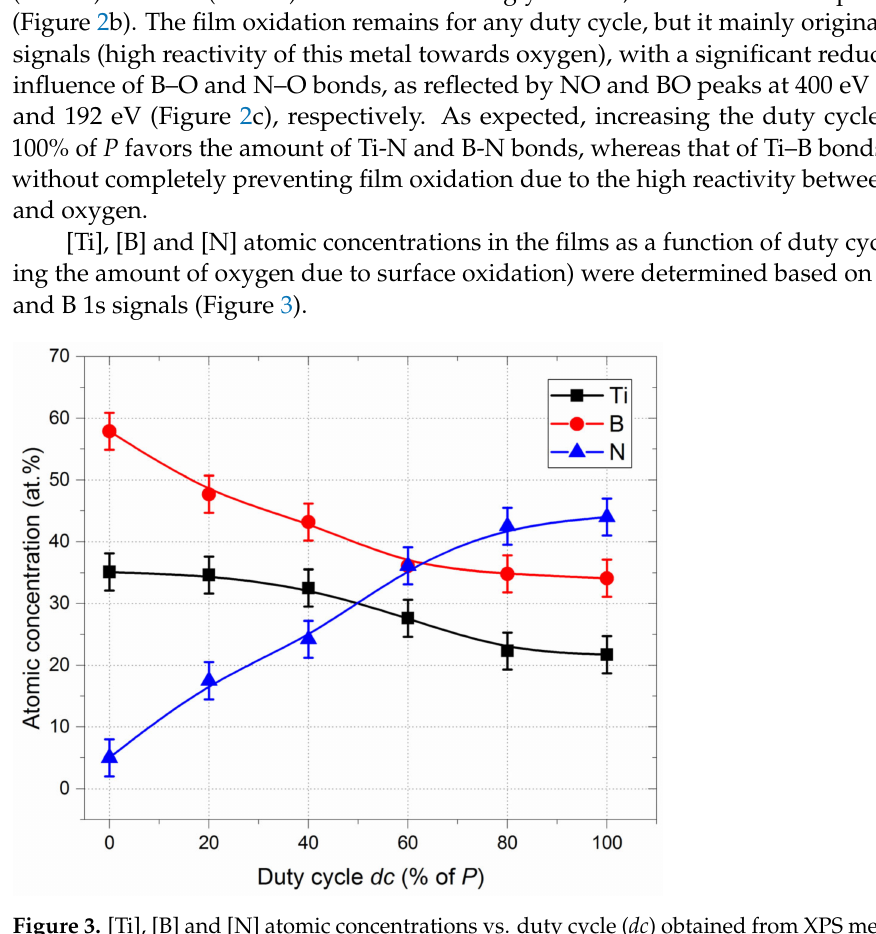
Figure 3. [Ti], [B] and [N] atomic concentrations vs. duty cycle ( dc ) obtained from XPS